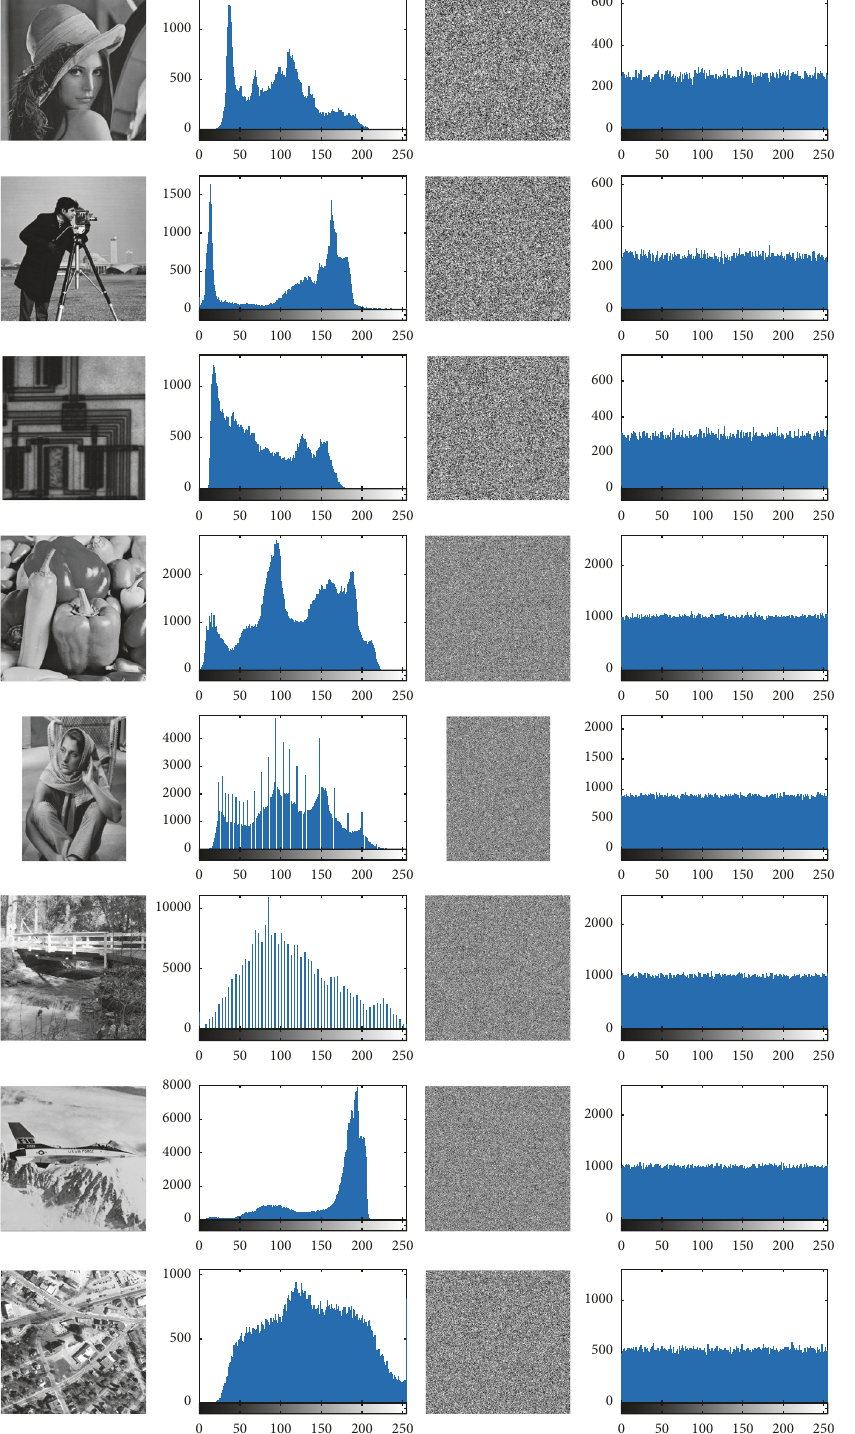
Figure 4: Histograms of the plain images and their corresponding cipher images. The first column is plain images. The second column is the histograms of the plain images. The third column is cipher images. And the fourth column is the histograms of the cipher